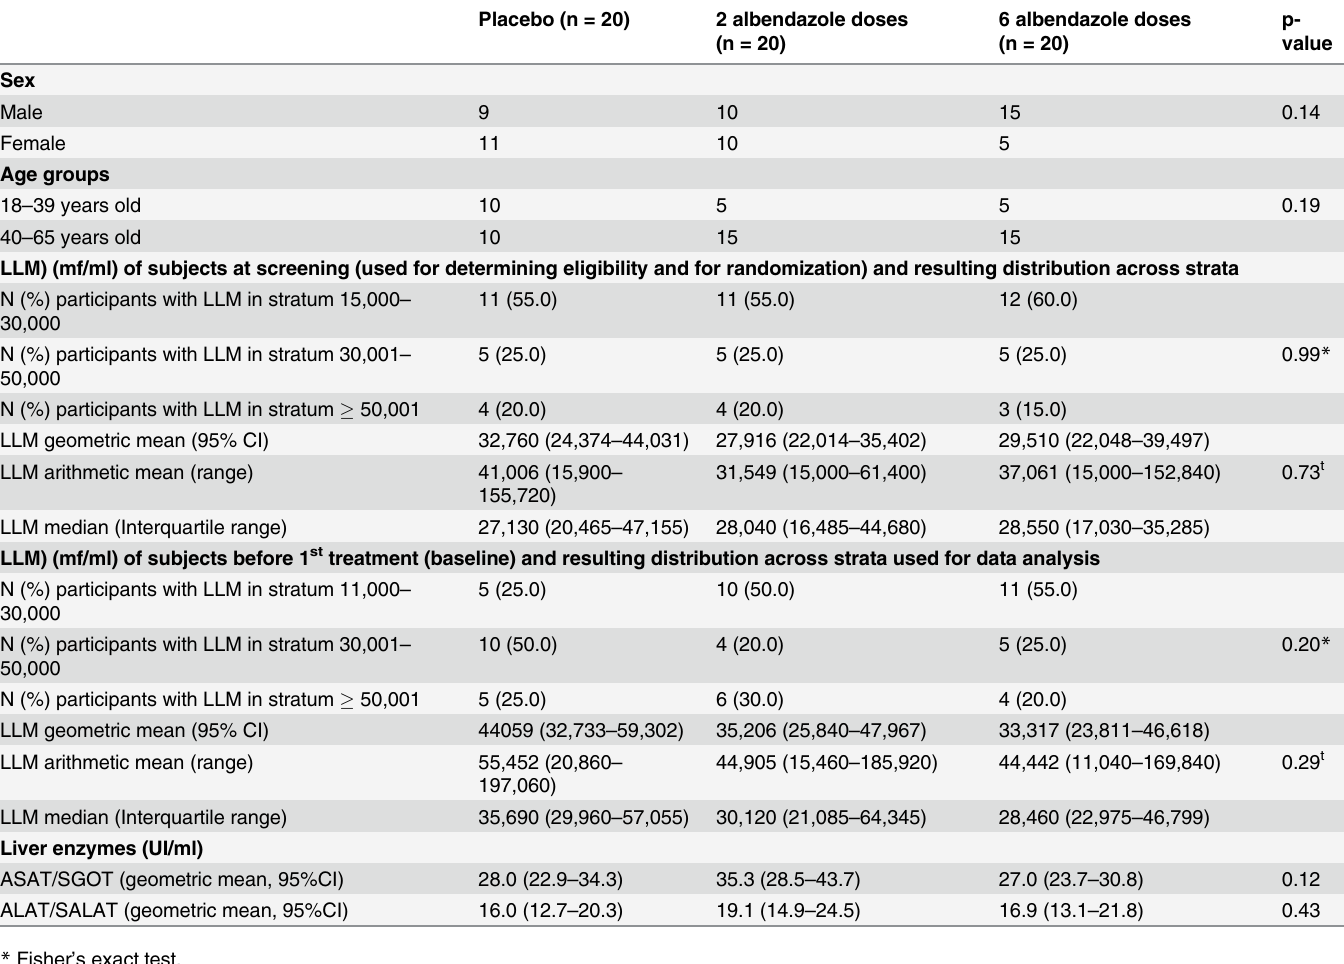
Table 2. Screening and pre-treatment (baseline) characteristics.